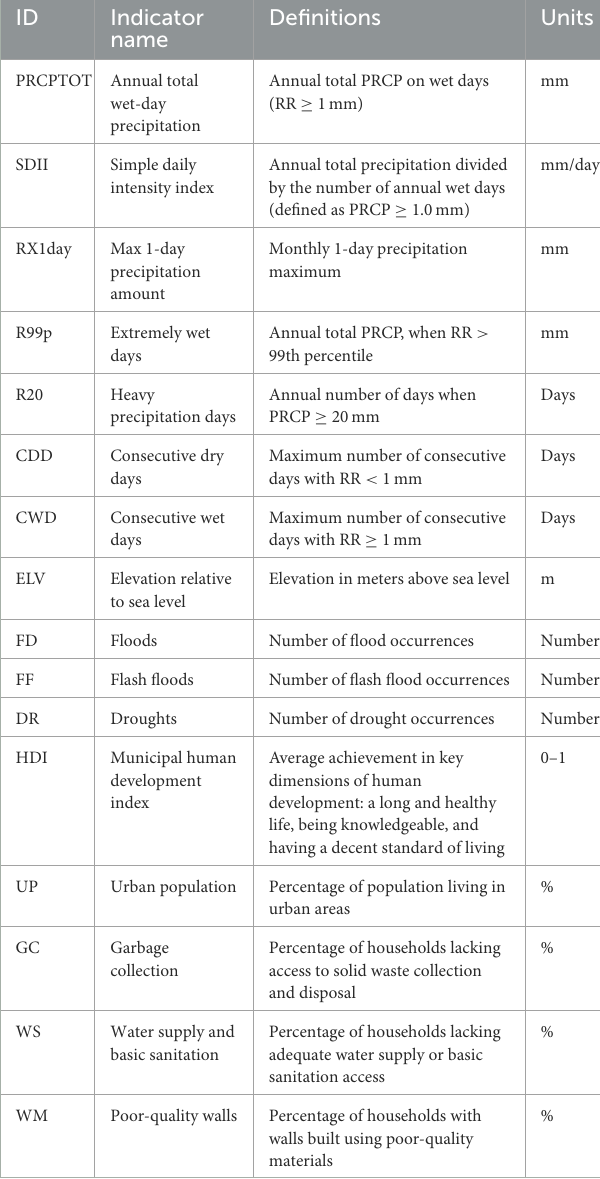
TABLE 1 Classes and descriptions of the study variables, comprising disaster type, climaticrmat, social, and sanitary